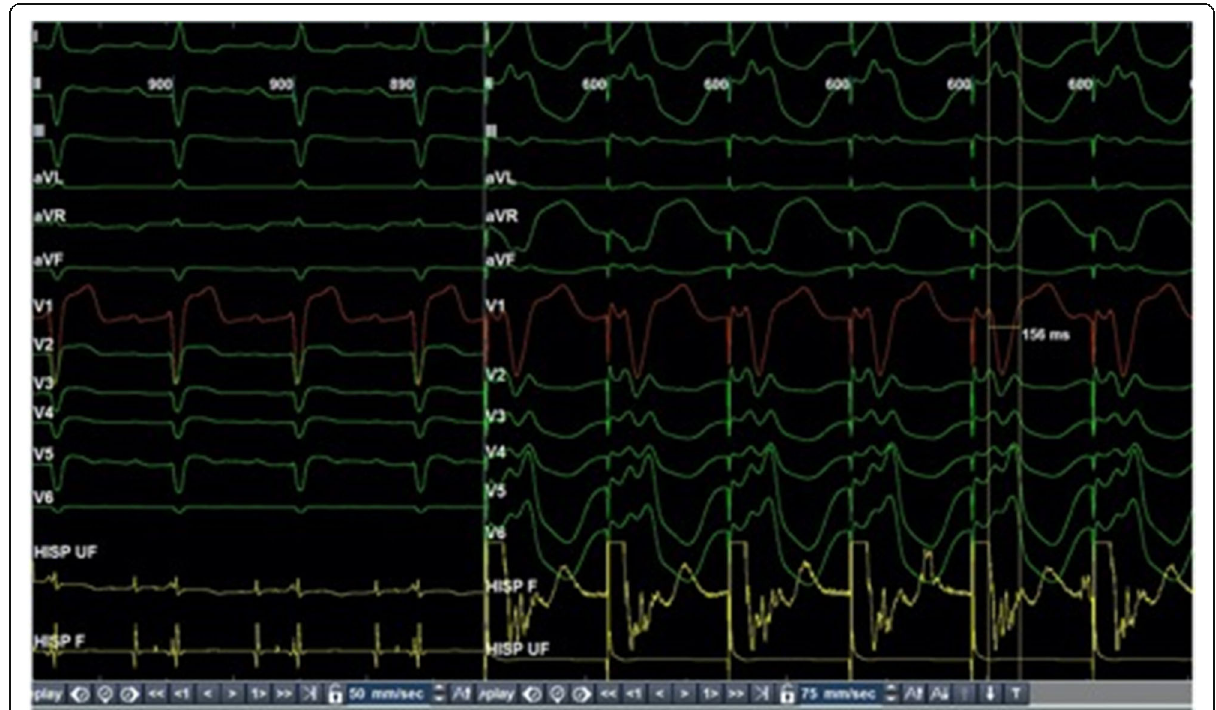
Fig. 4 Distal His position with large ‘ A ’ , wide paced QRS 154 ms and high threshold